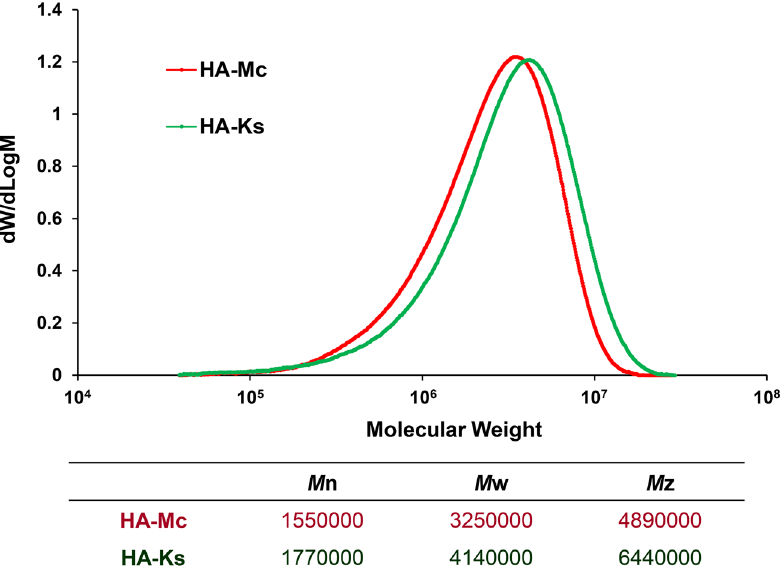
Figure 2. Comparison of average molecular weight between HA-Mc and HA-Ks. Molecular weight distributions of HA-Mc and HA-Ks were measured using size exclusion chromatography (SEC), and molecular weight distribution curves were created. Mw represents the weight-average molecular weight; Mn, the number average molecular weight; and Mz, the Z-average molecular weight. The weight-average molecular weight (Mw) has the strongest correlation with physical properties (especially viscosity). HA-Mc, sodium hyaluronate-based submucosal injection material (MucoUp); HA-Ks, sodium hyaluronate-based submucosal injection material